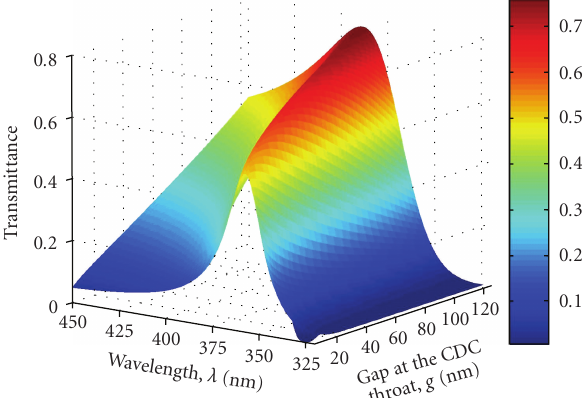
Figure 4: Transmittance in vacuum for CDC gratings as a function of the wavelength and distance at the gap of throat for the aluminum gratings having d = 315nm, a = 125nm, and t = 100